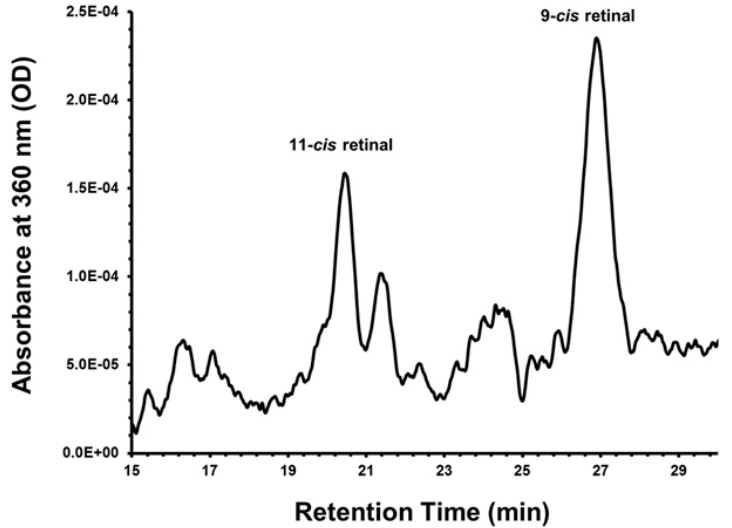
Figure 3. Retinoid metabolism in induced pluripotent stem cell (iPSC)-derived retinal pigment epithelium (RPE) monolayers. iPSC-RPE cells were cultured in 6-well plates until a confluent and pigmented monolayer was observed. Retinoid profiles were taken by monitoring the HPLC at 360 nm, two days post administration of 5 μ mol/L all- trans retinol (atRol) in 1% bovine serum albumin. iPSC-RPE cell cultures express 11- cis -retinal indicating functional retinoid metabolism. No hydroxylamine was used in these experiments; therefore, oximes are not detected. Note that significant quantities of the more stable 9- cis isomer are also formed with the administration of all- trans retinol. With the full permission of all authors of the original publication, Figure 6 of [76] has been included here.